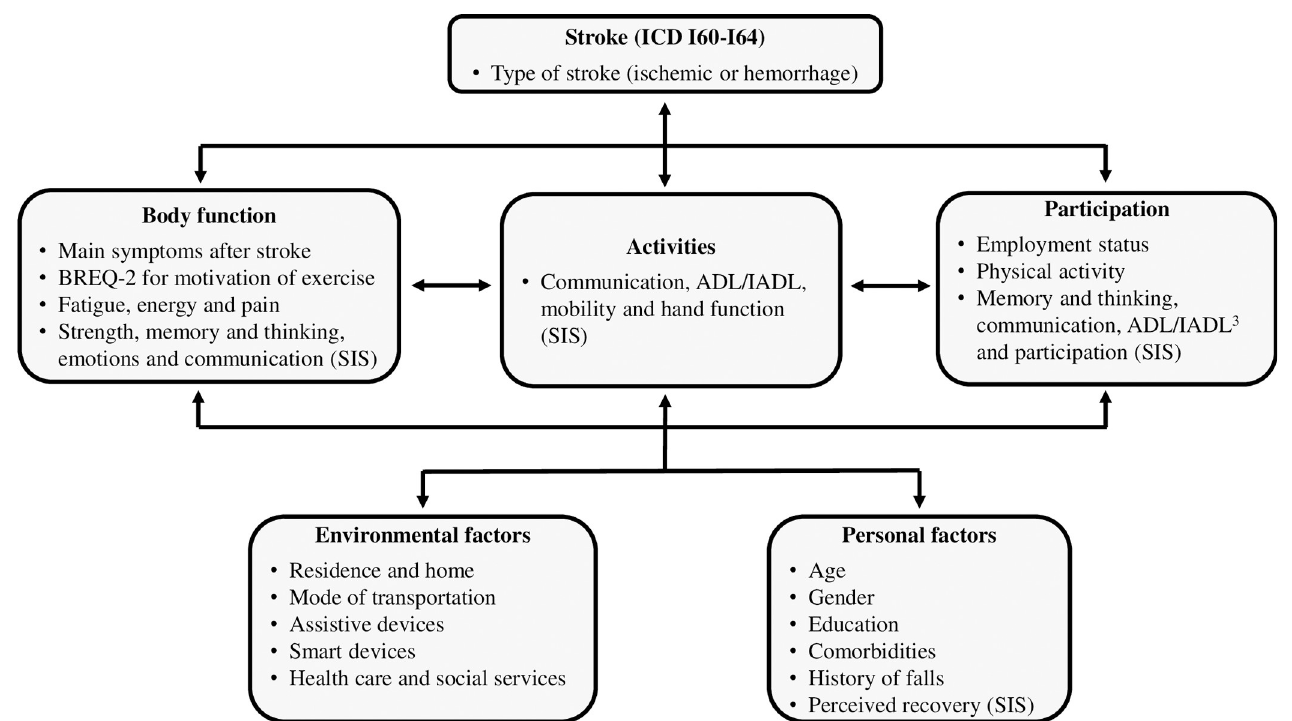
Fig 1. Linking of the questions in the survey to the components of the ICF